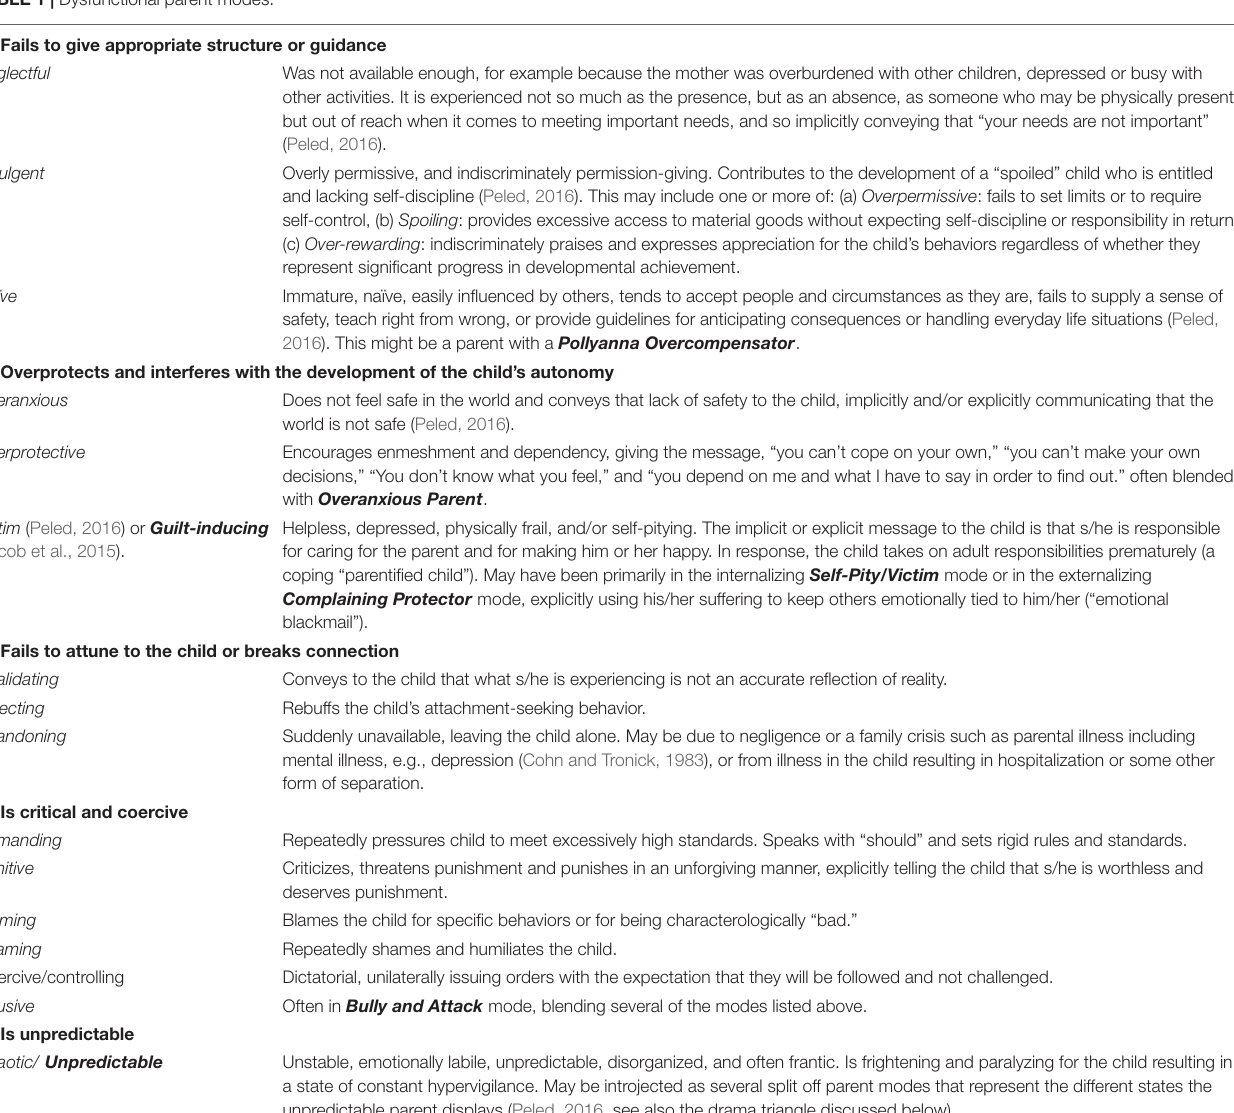
TABLE 1 | Dysfunctional parent